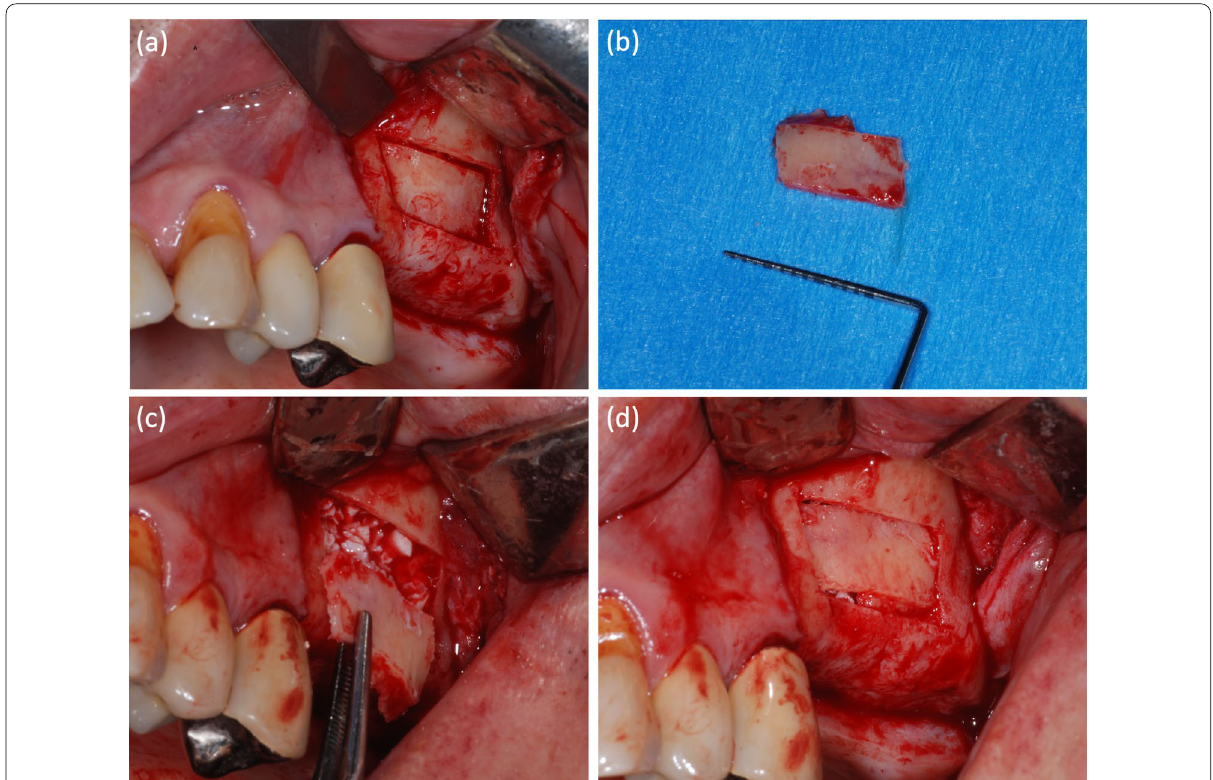
Fig. 3 a – d Photo sequence of a lateral sinus lift surgery with repositioned bone lid and heterologous bone